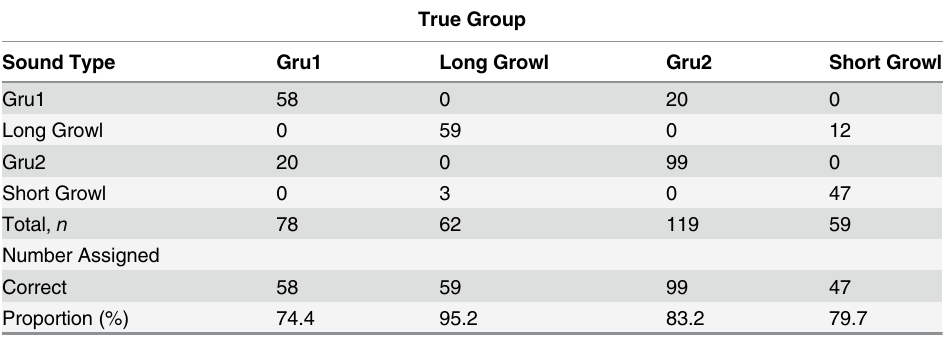
Table 1. Classification of sound types to four categories by linear discriminant